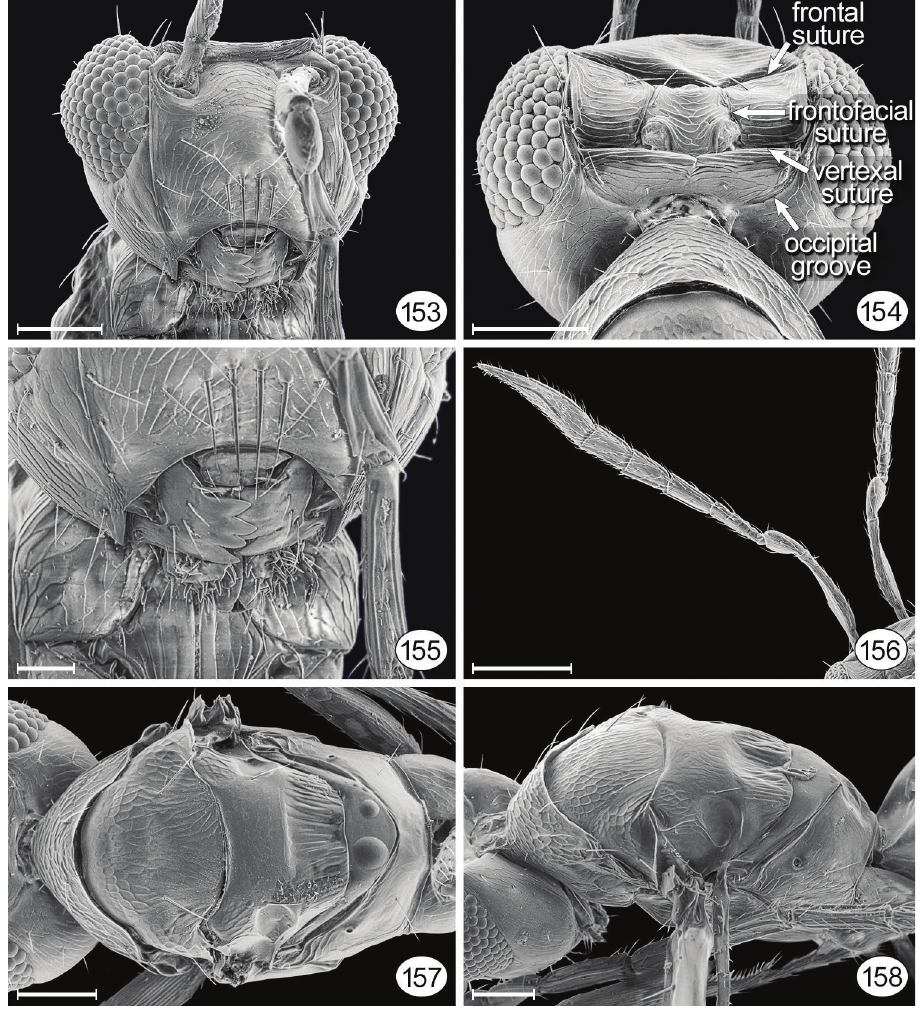
Figures 153–158. Proarescon similis . 153 male head, ventroanterior 154 female head and pronotum, posterodorsal 155 male lower face and prosternum 156 female antennae 157 female mesosoma, dorsal 158 male mesosoma, dorsolateral. Scale bar for 153, 154, 157, 158 = 50 μm; 155 = 20 μm; 156 = 100 μm. (Fig. 165). Malar space with 2 setae. Occiput with engraved transverse reticulate sculp- ture, with 1 short setae submedially and 1 sublaterally above occipital foramen. Gena with longitudinally reticulate sculpture laterally, becoming isodiametric around fora- men, and with about 5 setae sublaterally and laterally. Antenna. Fl –fl without mps, 1 5 Fl –fl each with 2 mps; clava with 6 mps. Length/width measurements: scape 166/-, 6 8 pedicel 39/-, fl 11/12, fl 13/12, fl 12/13, fl 15/14, fl 18/16, fl 50/16, fl 51/21, fl 1 2 3 4 5 6 7 8 54/31, clava 143/30. Mesosoma. Width 156 and length 287. Pronotum with raised transverse to isodiametric reticulate sculpture, with 3 long setae near posterior